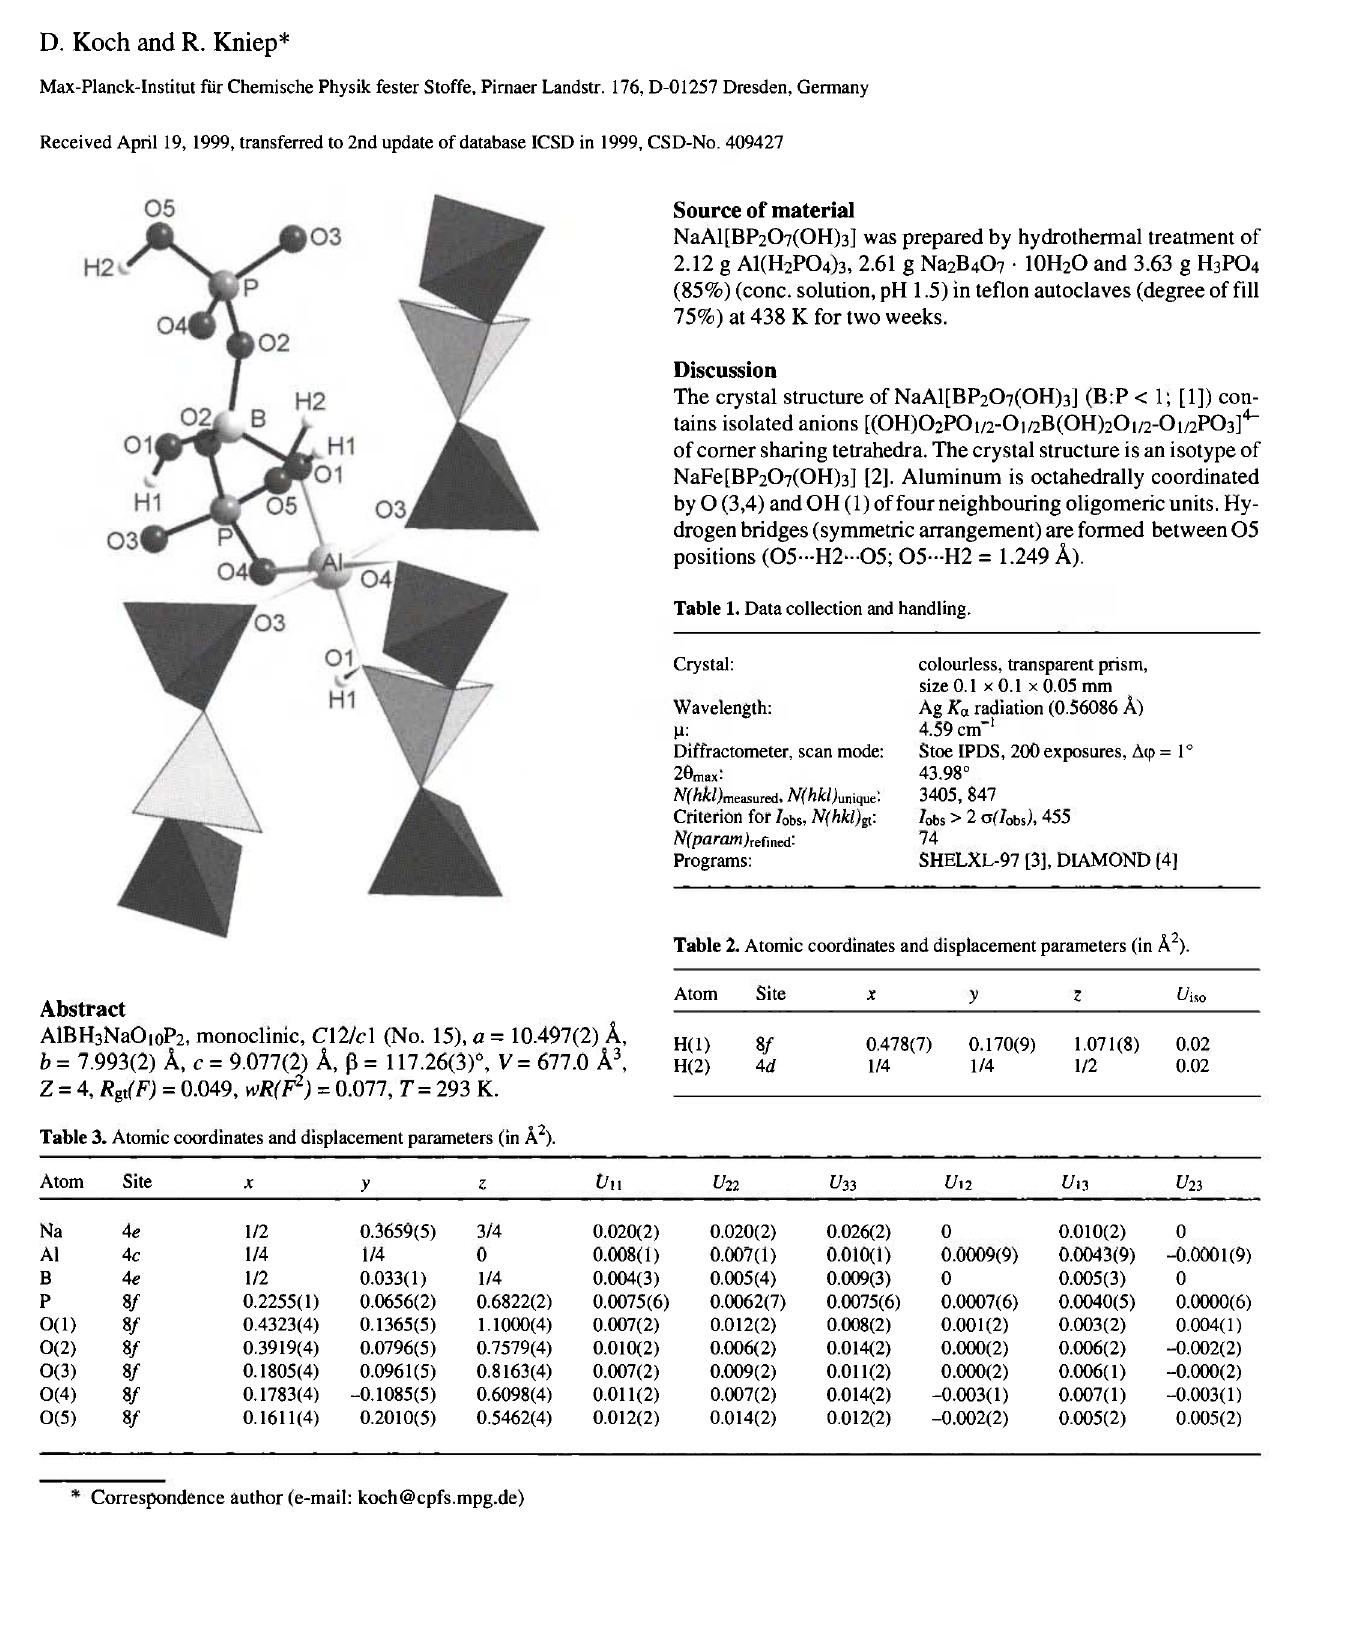
Table 1. Data collection and handling.